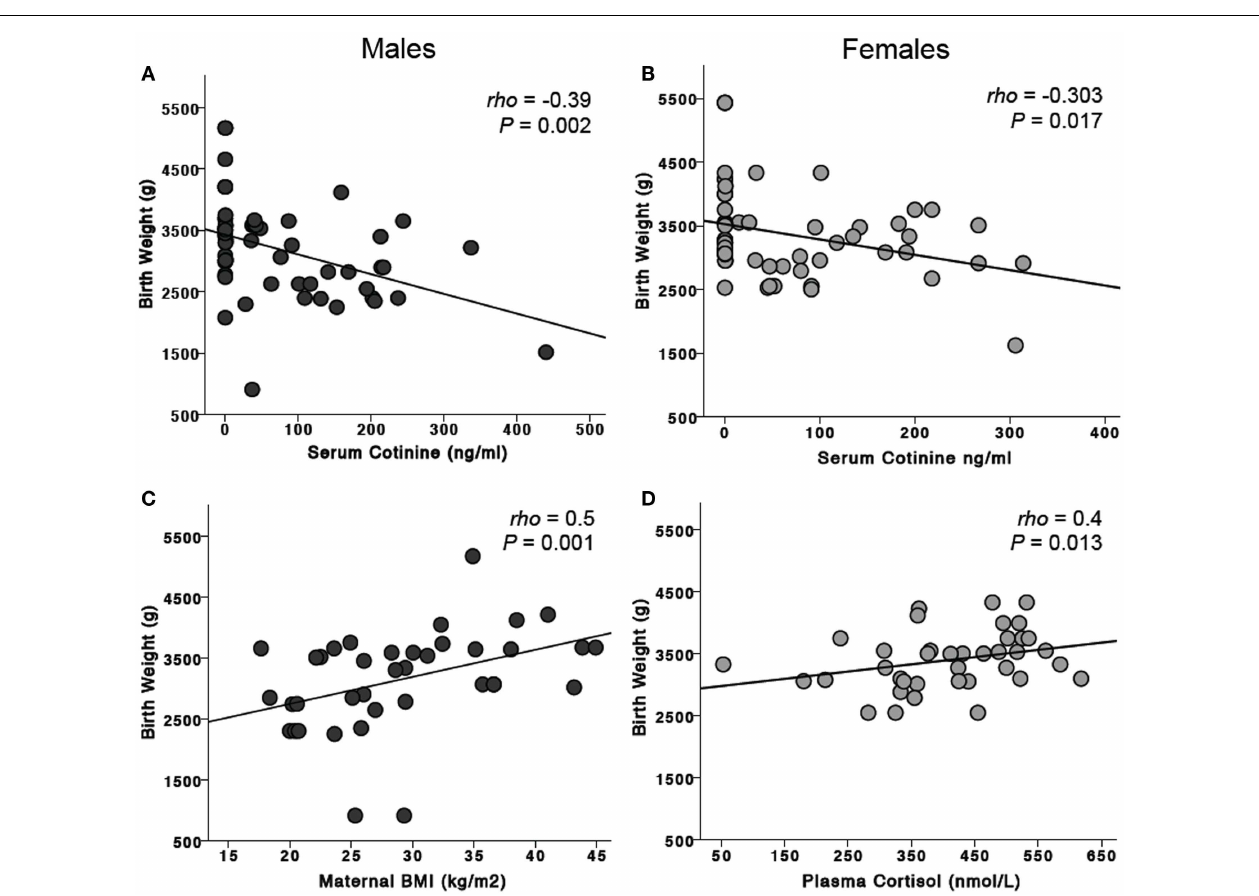
with birth weight for males (C) but not females. In contrast, maternal plasma cortisol was positively associated with birth weight for females (D) but not males.